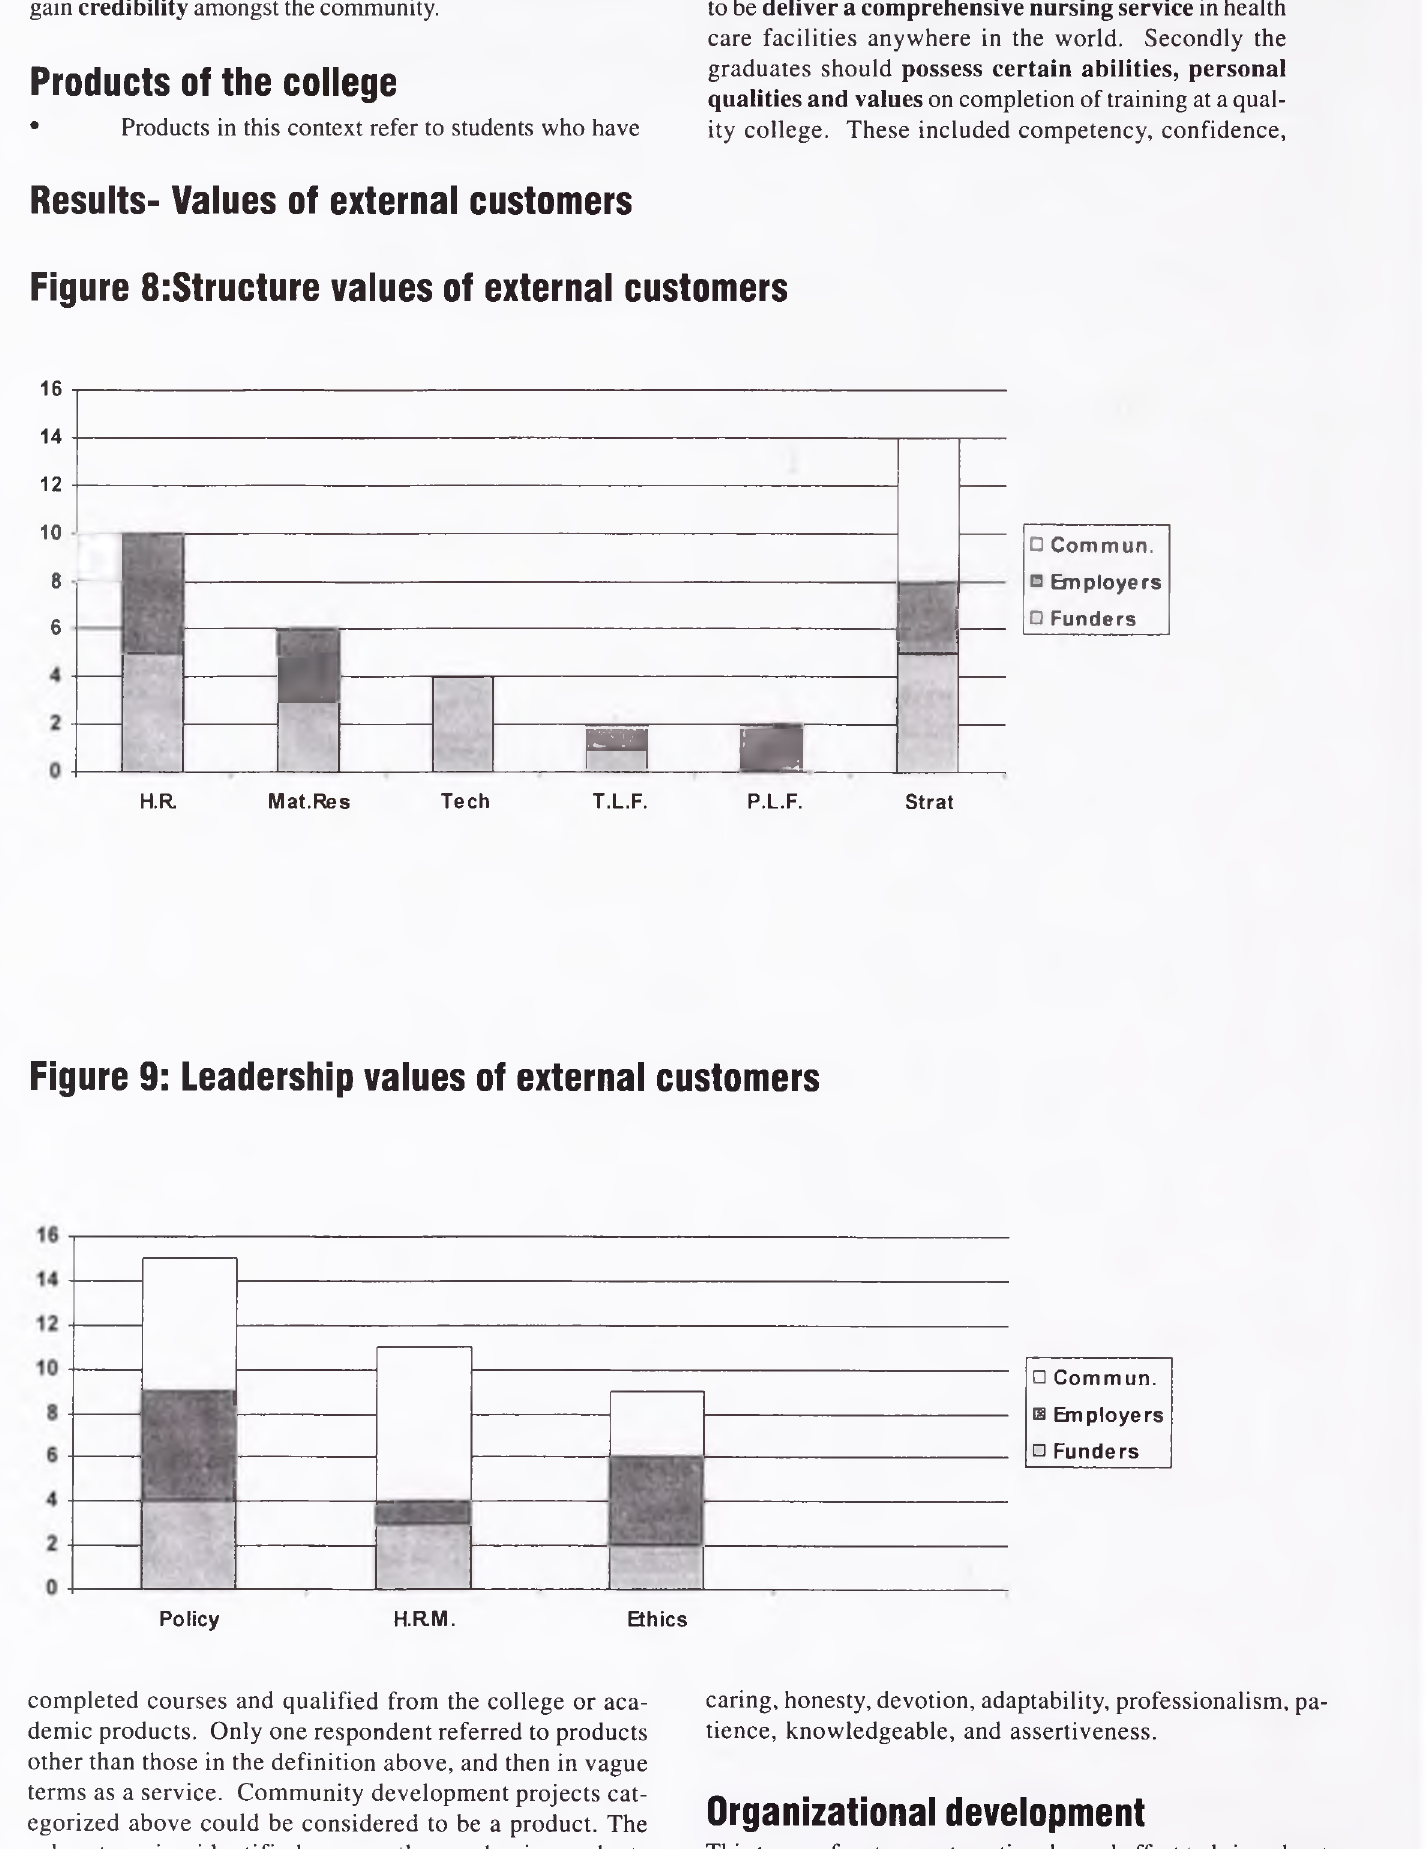
Figure 9: Leadership values of external